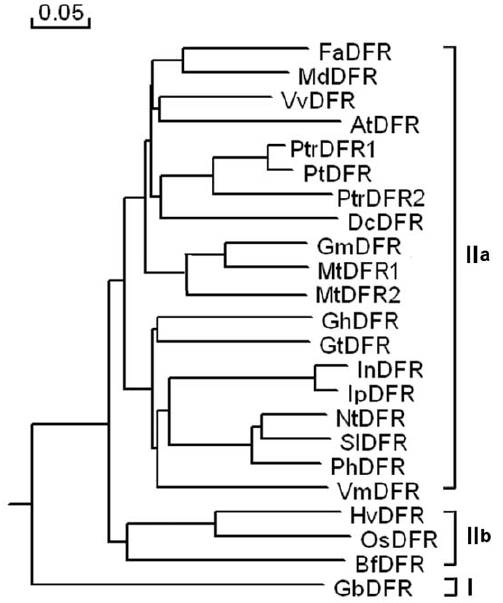
Figure 2. Phylogenetic relationships between PtrDFRs and other DFR proteins from other plant species. Phylogenetic and evolutionary analyses were performed using the neighbor-joining method by DNAMAN software. Additional sequences include